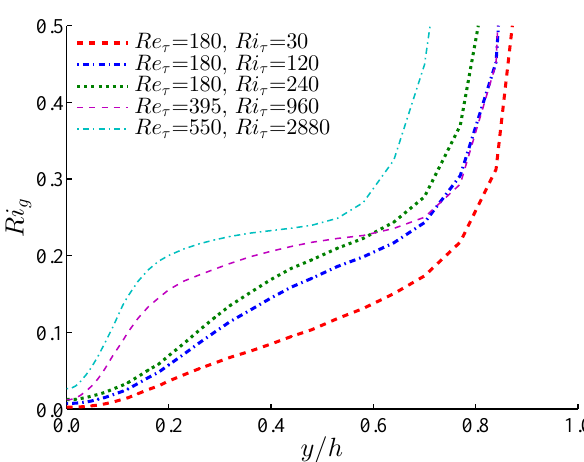
Figure 15. Vertical distribution of gradient Richardson number ( Ri g ) in the channel.